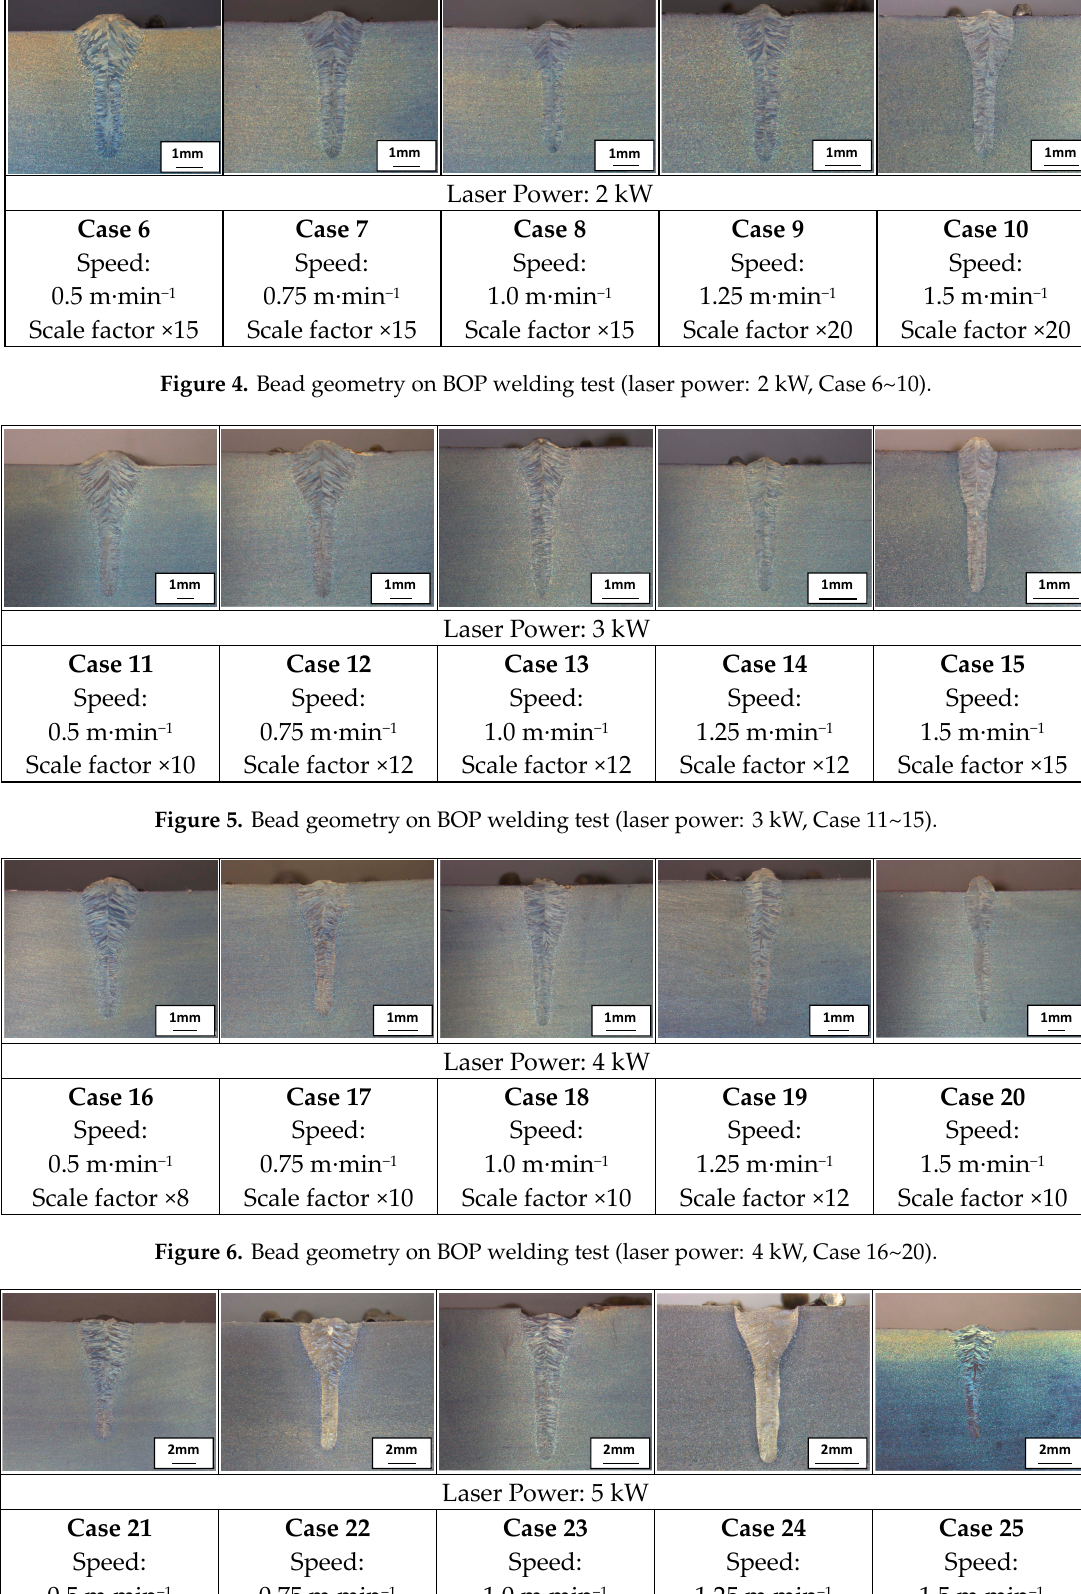
Laser Power: 5 kW